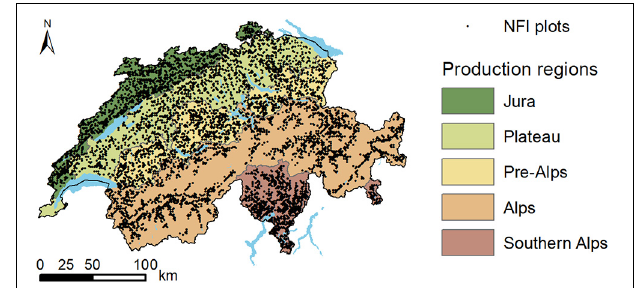
FIGURE 1 | Map of Switzerland with NFI plots (black dots) within five NFI production